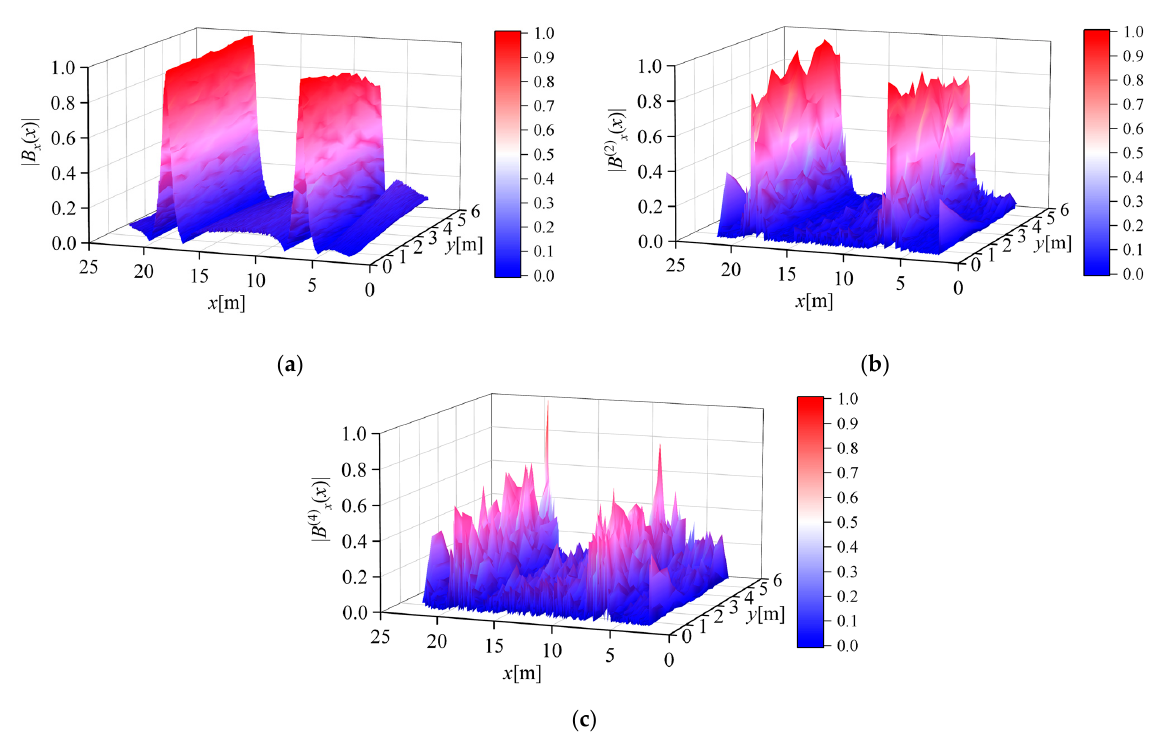
Figure 11. Normalized magnetic flux density absolute value measurement results when the measurement step size d = 0.02 m: ( a ) magnetic flux density; ( b ) second-order differential of the magnetic flux density; ( c ) fourth-order differential of the magnetic flux density.